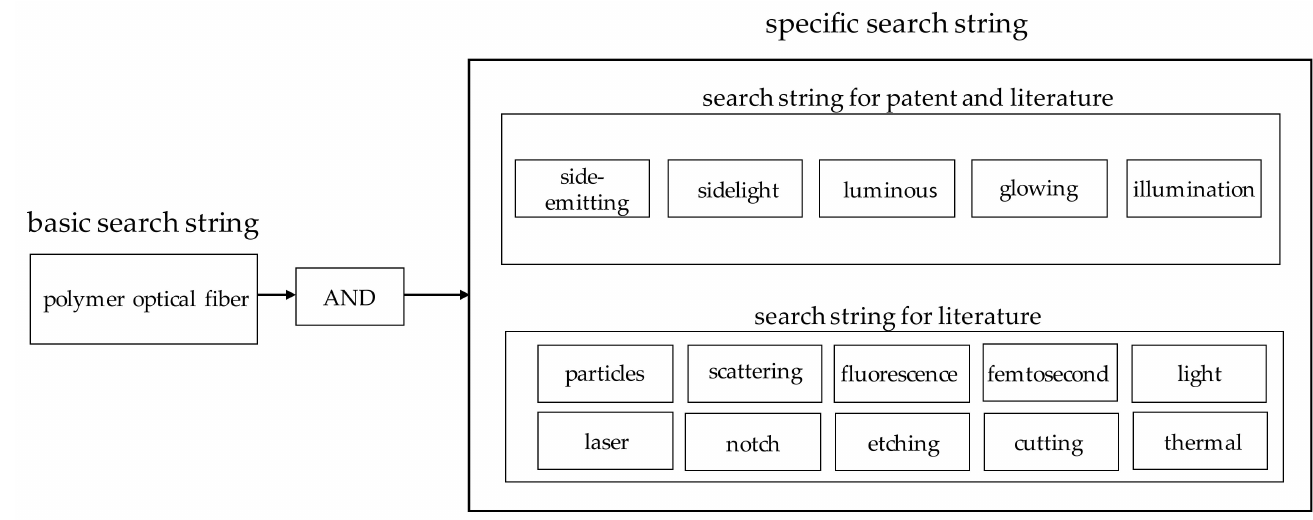
Figure 2. Search string generation for patent and literature research of SE-POF.